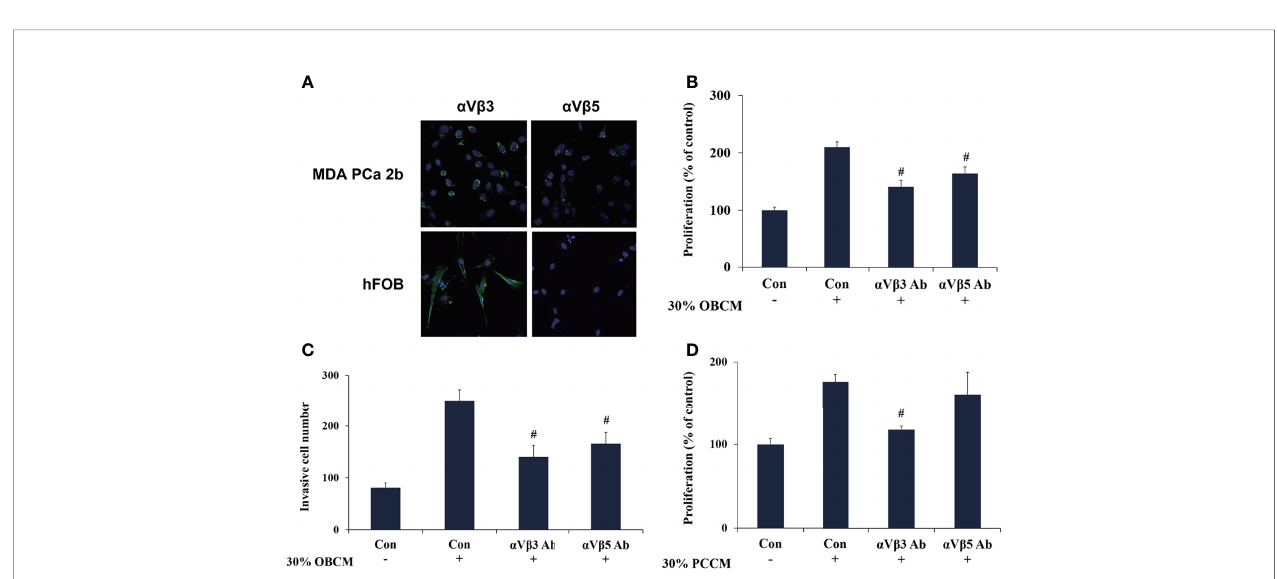
FIGURE 7 | POSTN functions in PCa cells and osteoblasts via integrin receptors. (A) Immuno fl uorescence staining of a V b 3 and a V b 5 in MDA PCa 2b and hFOB cells. (B) MDA PCa 2b cells were incubated with 30% OBCM and a V b 3 or a V b 5 antibody. Cell proliferation was assessed. (C) MDA PCa 2b cells were incubated with 30% OBCM and a V b 3 or a V b 5 antibody. Invasions were assessed. (D) hFOB cells were incubated with 30% PCCM and a V b 3 or a V b 5 antibody. Cell proliferation was assessed. # p < 0.05 compared with the OBCM- or PCCM-treated